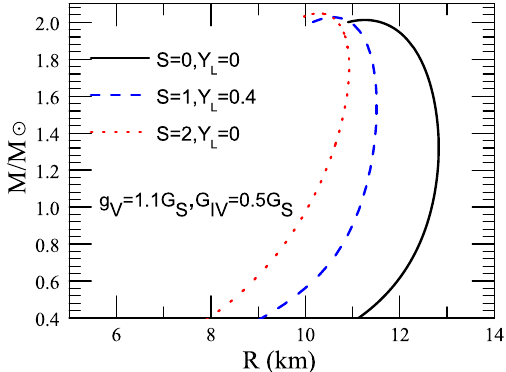
Fig. 7 The mass–radius relation for proto-quark stars from SU(3) NJL model within different vector interaction.